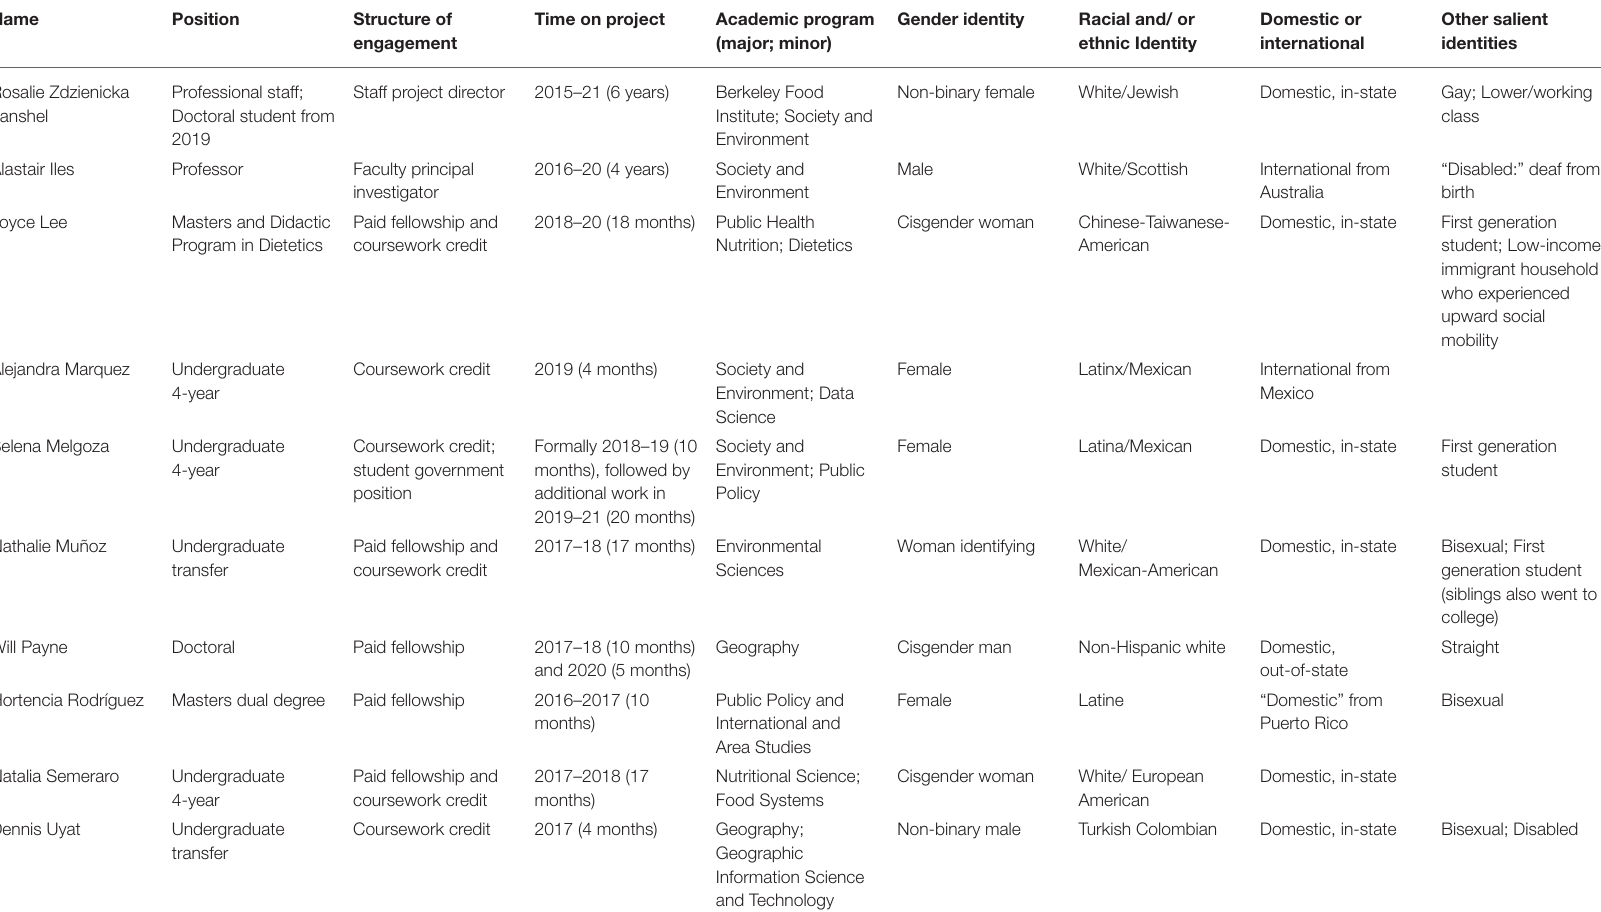
TABLE 2 | Author and interviewee positions and